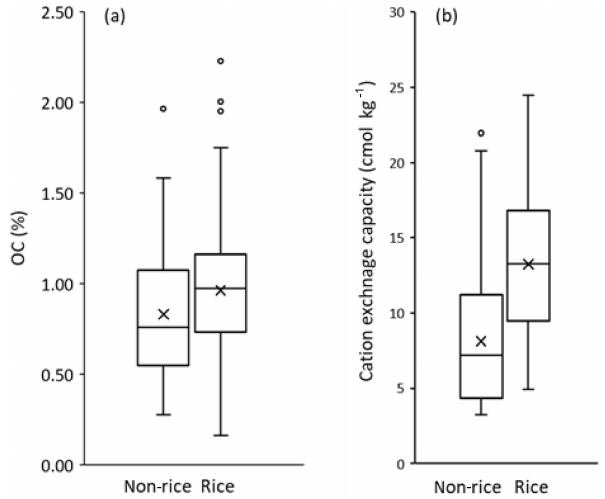
Figure 3. (a) Soil organic carbon and (b) cation exchange capacity across seven EIP